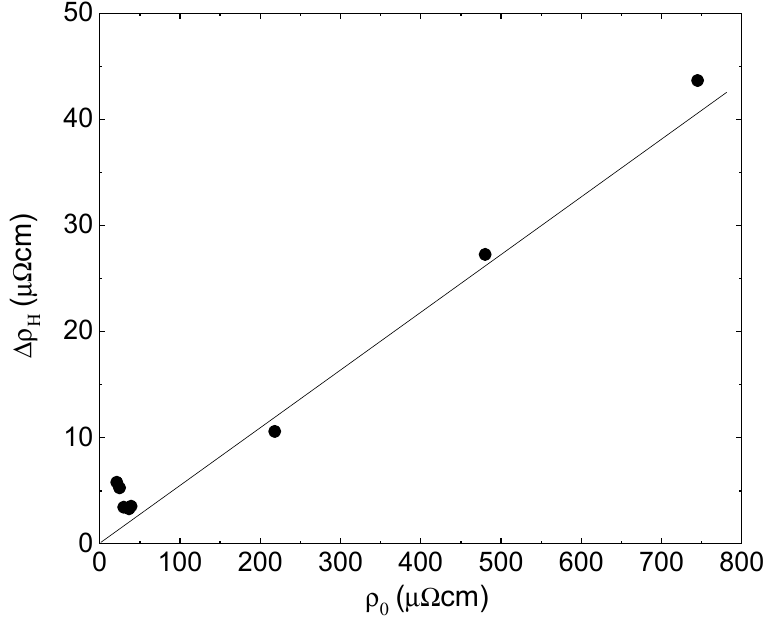
Figure 5. The hydride scattering resistivity term ∆ ρ H as a function of resistivity for films of different thicknesses. A solid line is a guide to the eye.